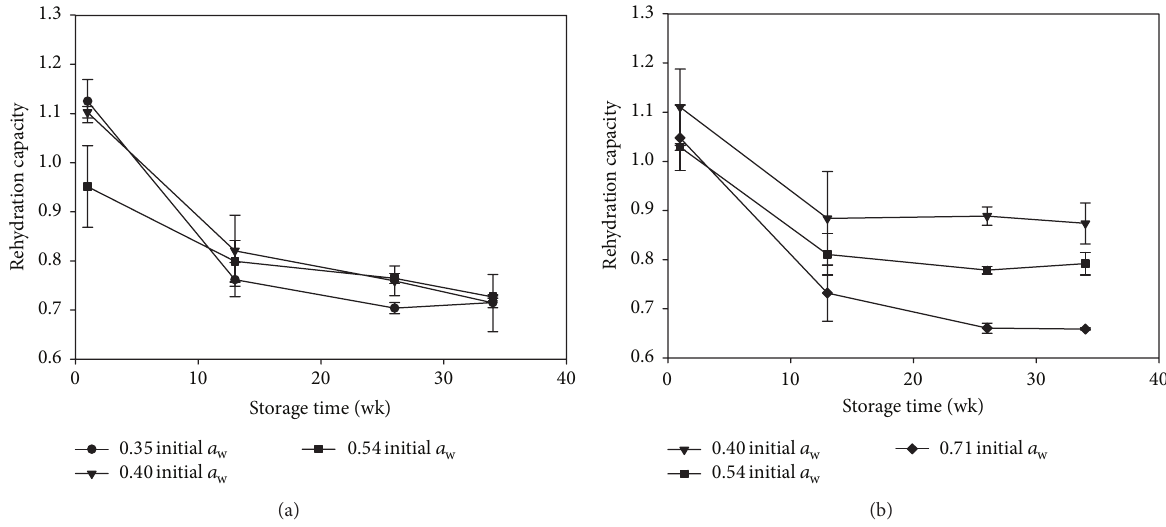
Figure 1: Dimensionless rehydration capacity of dehydrated taro slices dried to different 𝑎 laminate pouches at 45 ∘ C and 75% RH for 34 weeks ( 𝑛 = 3 ).